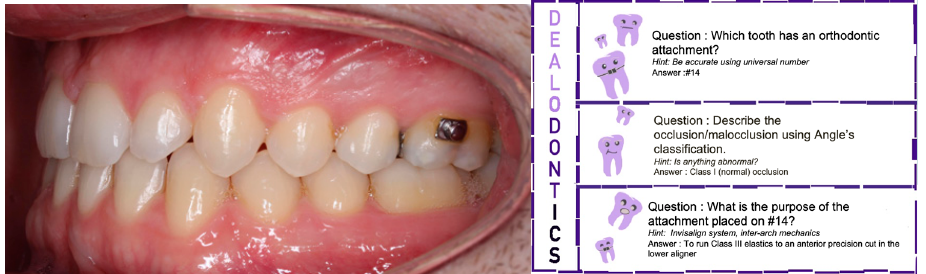
Figure 1. Sample game card used in playing Dealodontics© Teams only see the image. The reverse side with questions of increasing difficulty is seen by the dealer.